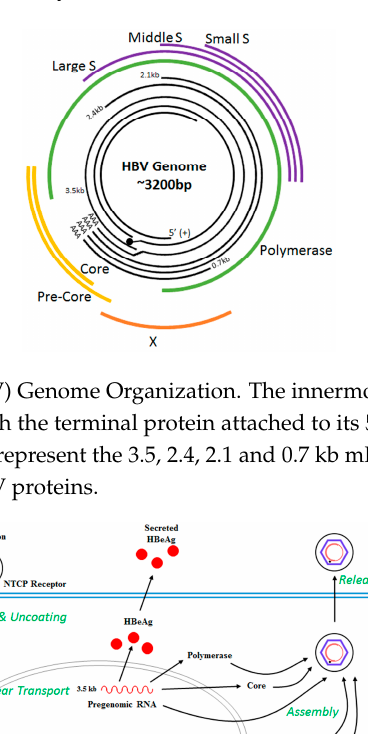
Table 1. Genes and Proteins encoded by Hepatitis B Virus (HBV).